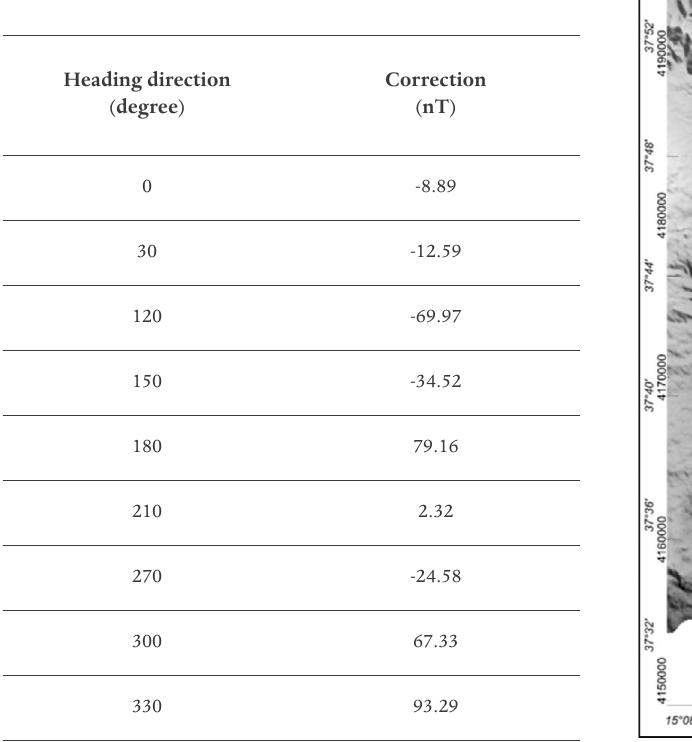
Clockwise from top: Table 1. Summary and main description of the samples collected by ROV during the cruise. Figure 8. Map of difference between levelled magnetic anomaly and raw data. Grid cell size is 200 m. In light grey, the survey track lines are overlaid. In the inset, the detailed histogram statistic distribution of crossover errors is reported. CH (Chiancone volcanoclastic deposit), TA (Timpa area). Table 2. Heading correction table obtained comput- ing the mean magnetic values for each different heading direction and subtracting these from the average magnetic anomaly field of the whole area (−70.49